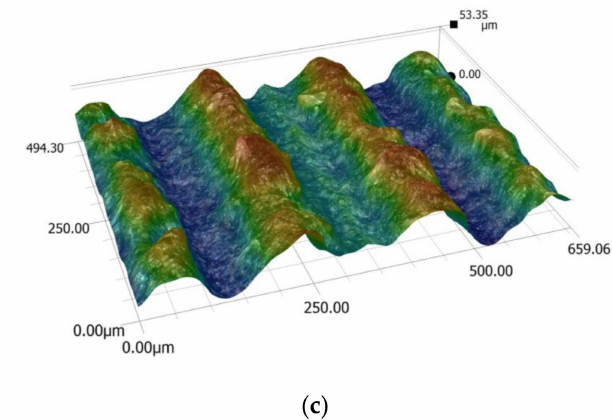
Figure 18. The macroscopic view of the surface of West African Ebony after turning with 3ER (TH) with a depth of